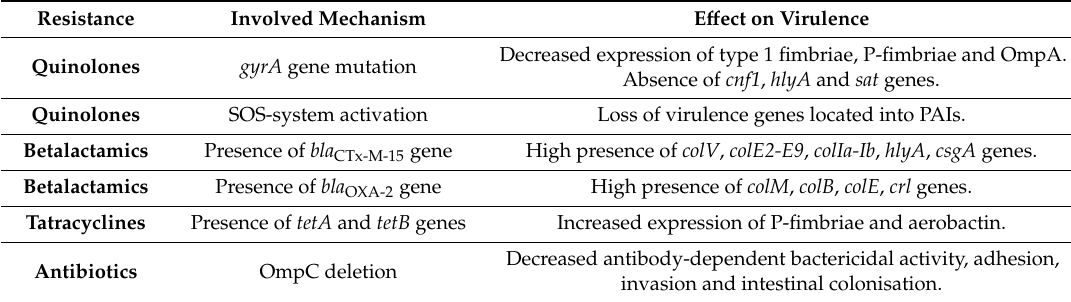
Table 1. Relationship resistance-virulence among E. coli explained in this